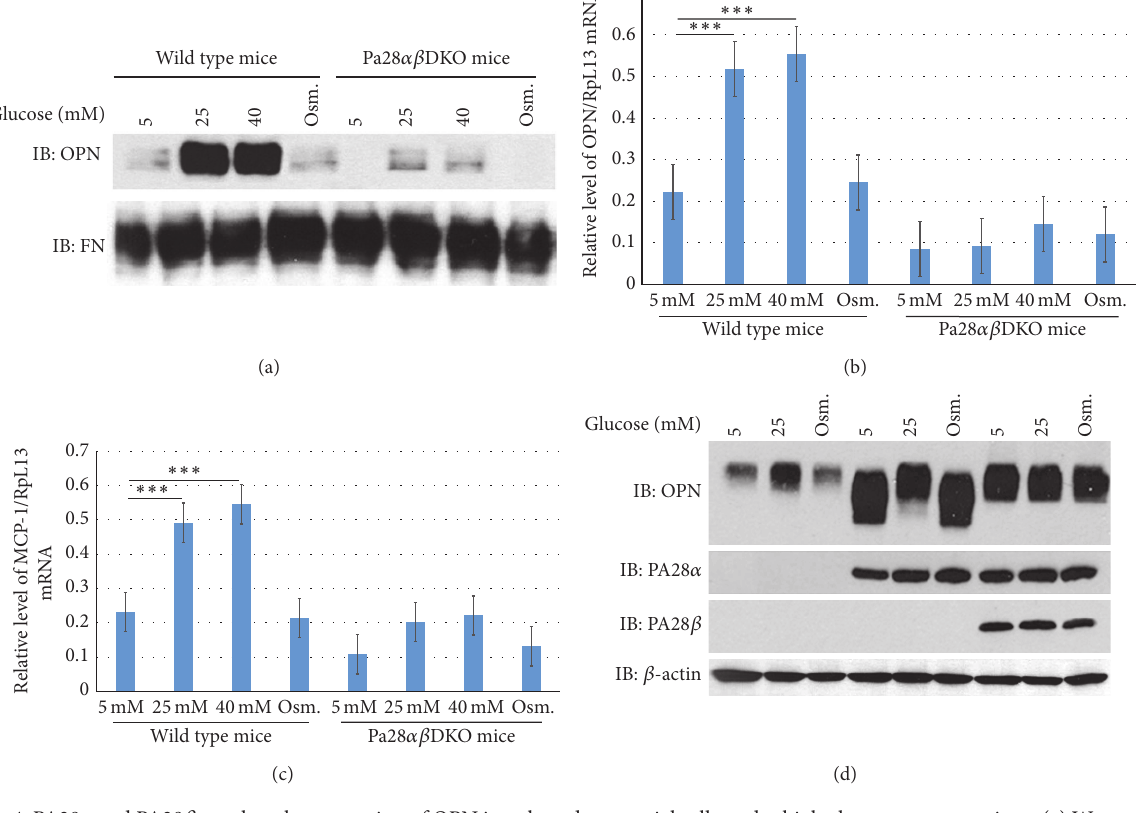
Figure 4: PA28 𝛼 and PA28 𝛽 regulate the expression of OPN in cultured mesangial cells under high glucose concentrations. (a) Western blot analysis of the conditioned media of cultured wild type and Pa28 𝛼𝛽 DKO mesangial cells under different glucose conditions and osmolarity treatment. OPN: Osteopontin and FN: Fibronectin. (b) qPCR analysis of OPN and (c) MCP-1 mRNA in wild type and Pa28 𝛼𝛽 DKO mesangial cells under different glucose concentrations. (d) Western blot analysis for OPN in the conditioned media and PA28 𝛼 , PA28 𝛽 , and 𝛽 -actin in the cell lysate following lentiviral reexpression of PA28 𝛼 and PA28 𝛼 /PA28 𝛽 in Pa28 𝛼𝛽 DKO mesangial cells. Results presented as mean ± SEM. ∗∗∗ 𝑝 < 0.001